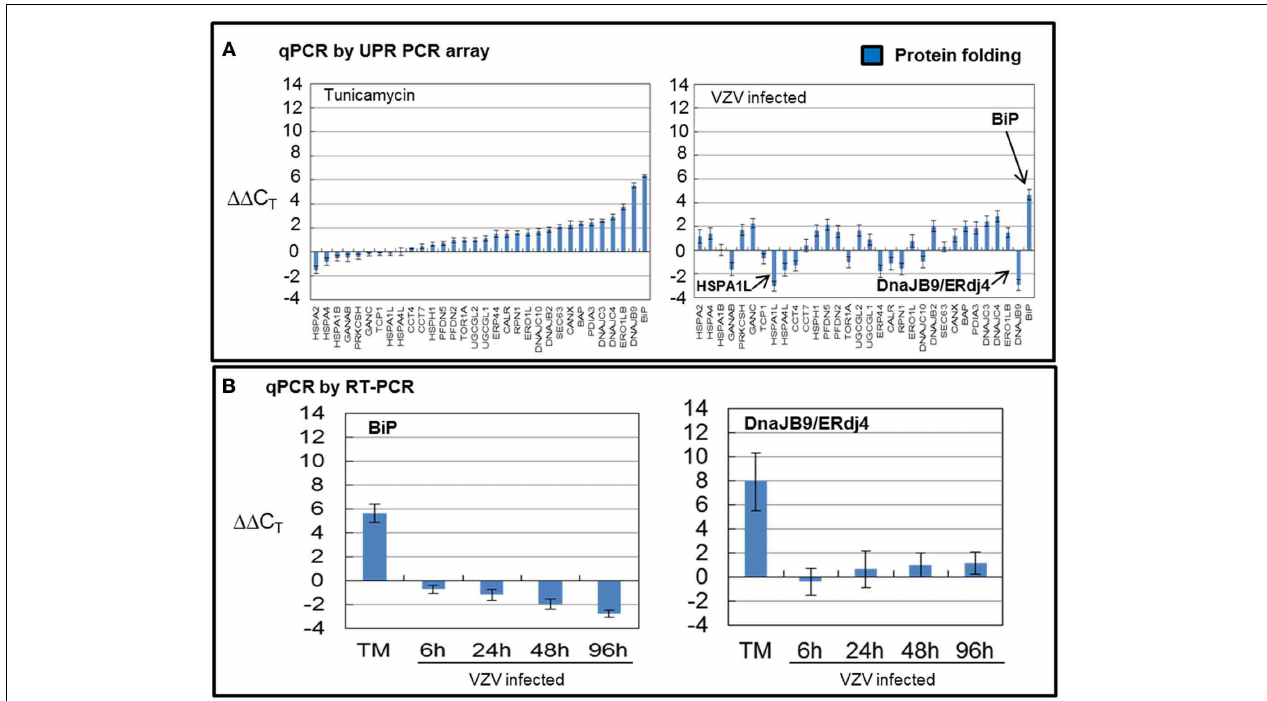
FIGURE 4 | VZV infected cells exhibited uneven transcription of protein folding genes. Human fibroblast cells (MRC-5) were grown in tissue culture plates then infected with VZV-32 infected MRC-5 cells or treated with tunicamycin (TM), a N-glycosylation inhibitor. At 72 hpi, RNA was processed as described in legend to Figure 2 . All gene transcription measurements were graphed for tunicamycin treated and VZV infected cell samples. (A) Using the UPR specific PCR array, tunicamycin treated cells exhibited significant upregulation of transcripts